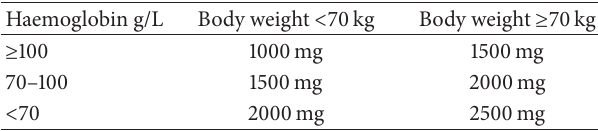
Table 4: Novel iron dosing strategy based on body weight and Hb levels as proposed by Evstatiev et al.